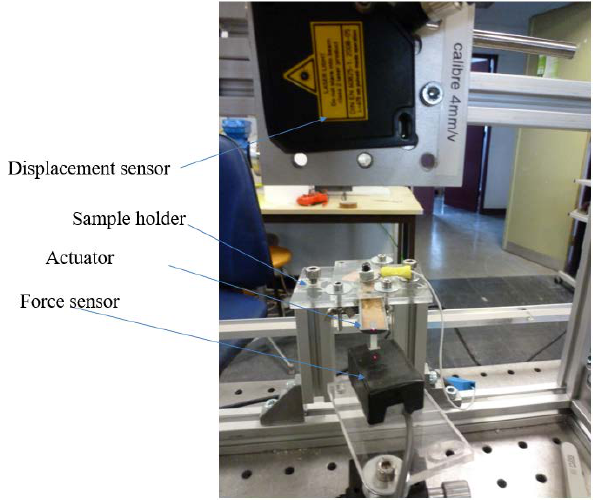
Figure 8. Photo of the test bench.